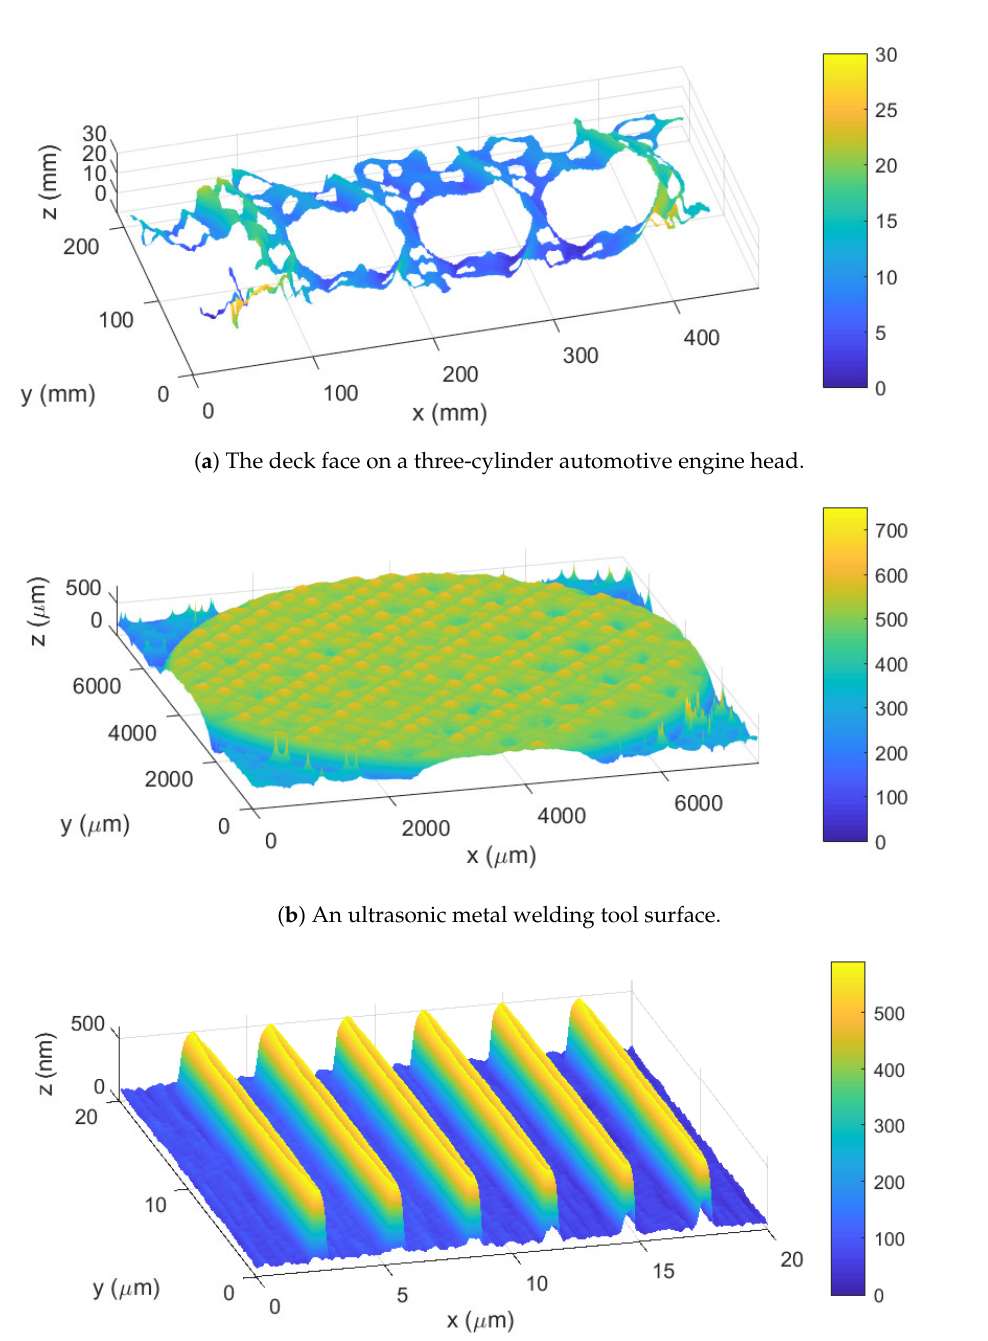
Figure 1. Examples of data visualization for surface measurement applications at different